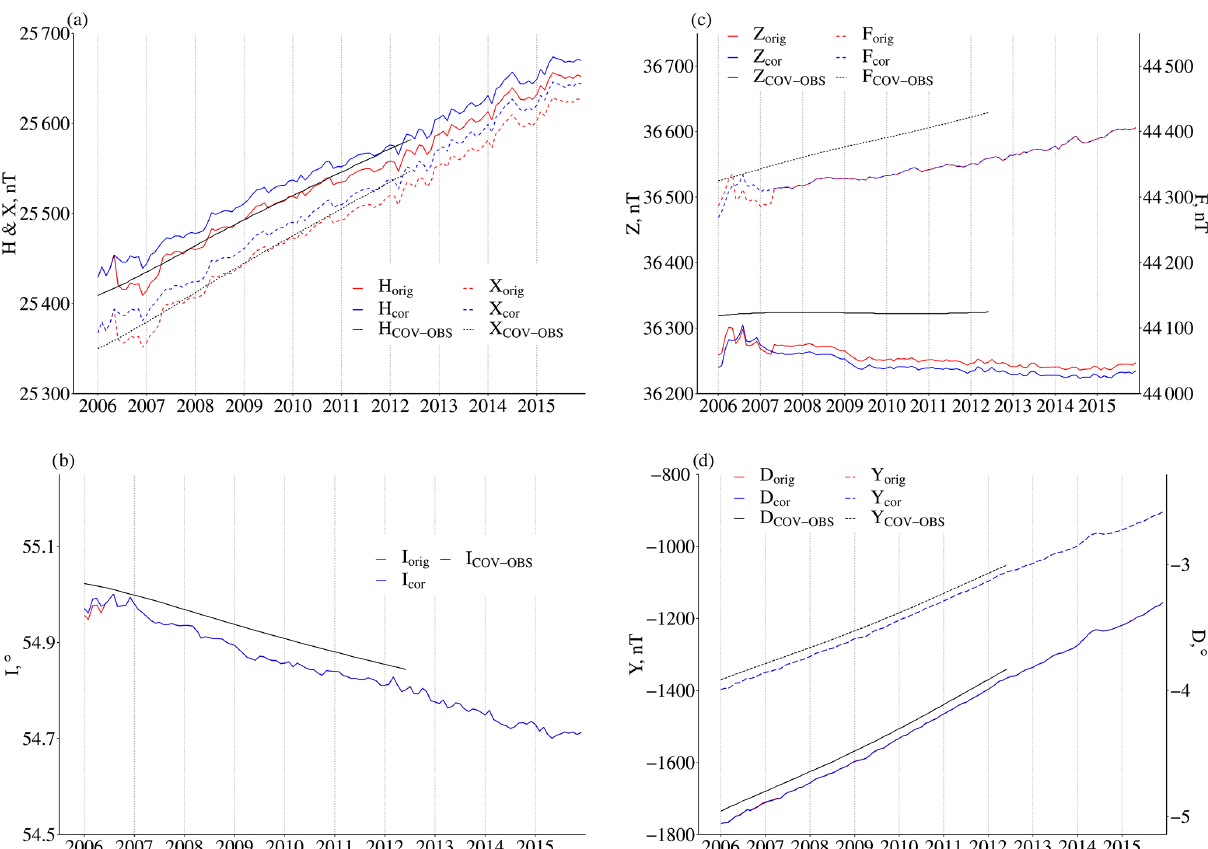
Figure 8. For the 2006–2015 time period, measured (red; orig) and corrected (blue; cor) series of the COI geomagnetic field elements (a) H and X , (b) I , (c) F and Z , and (d) D and Y . The COV-OBS model predictions are in